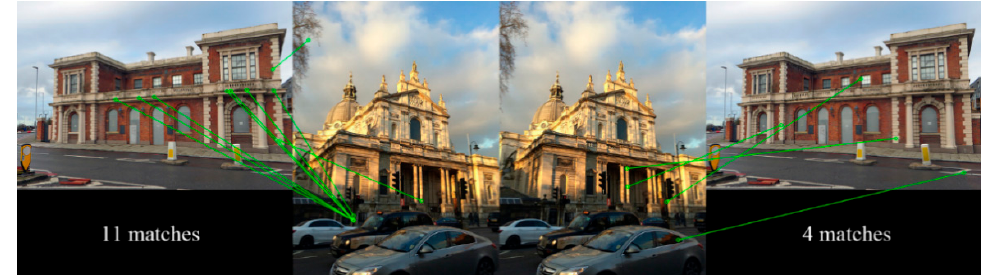
Figure 7. Different matching results of two matching directions. Figure 7. Di ff erent matching results of two matching